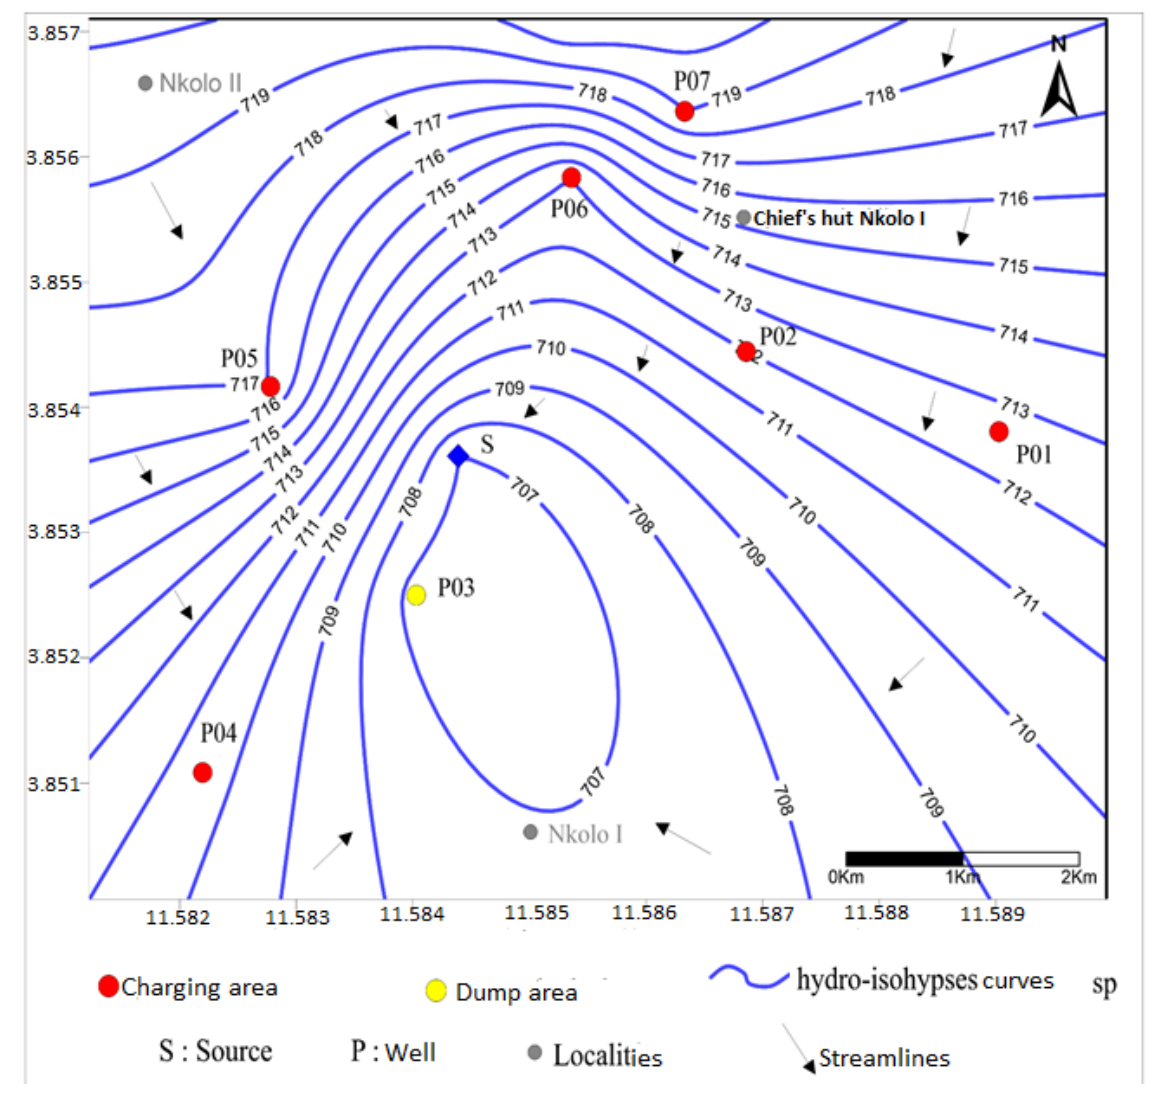
Figure 5. Maximum piezometric map (rainy season) of the Nkoabang aquifer. (P1): Nkolo I; (P2): Nkolo II (near the solidarity health centre); (P3): at the Etambè primary school; (P4): Etambè Catholic church; (P5): Nkolo I (near to the chief ’s hut); and (P6 and P7): Nkolo I (near the fountain).